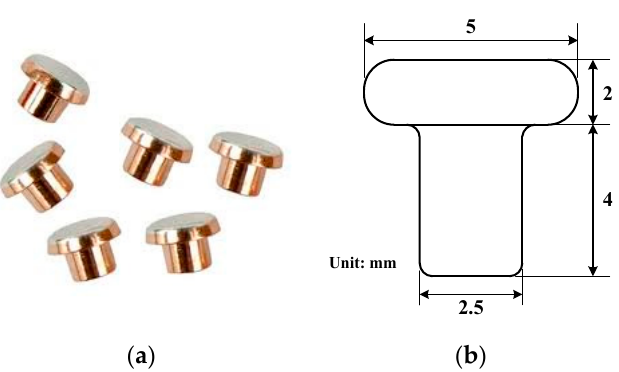
Figure 7. The appearance and dimension parameters of the rivet contact. ( a ) Appearance of the rivet contacts. ( b )The dimension parameters of specimen.